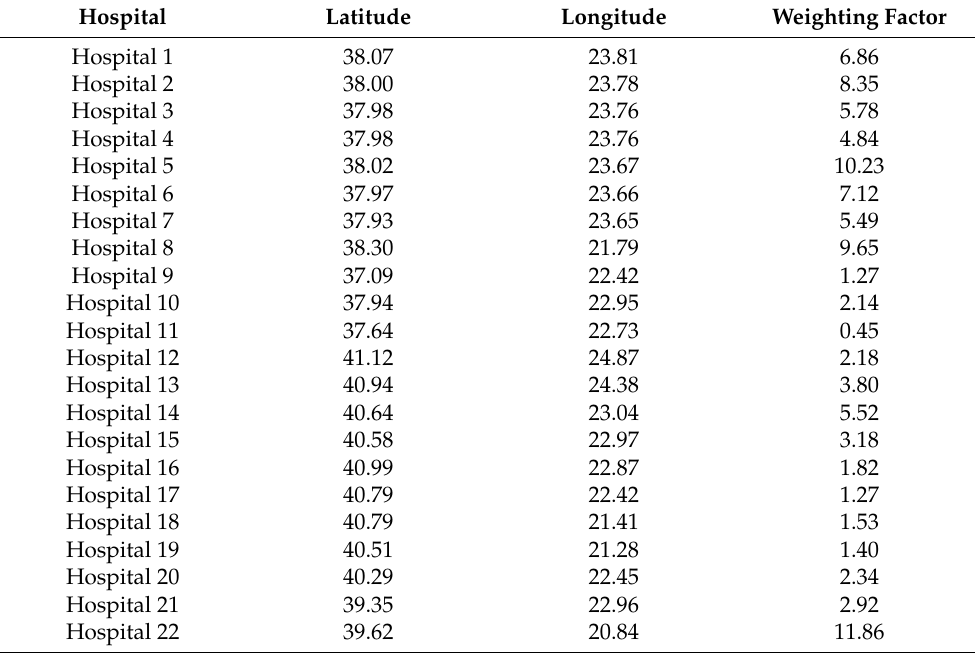
Table 4. Geographical position and weighting factor of hospitals considered in the study.